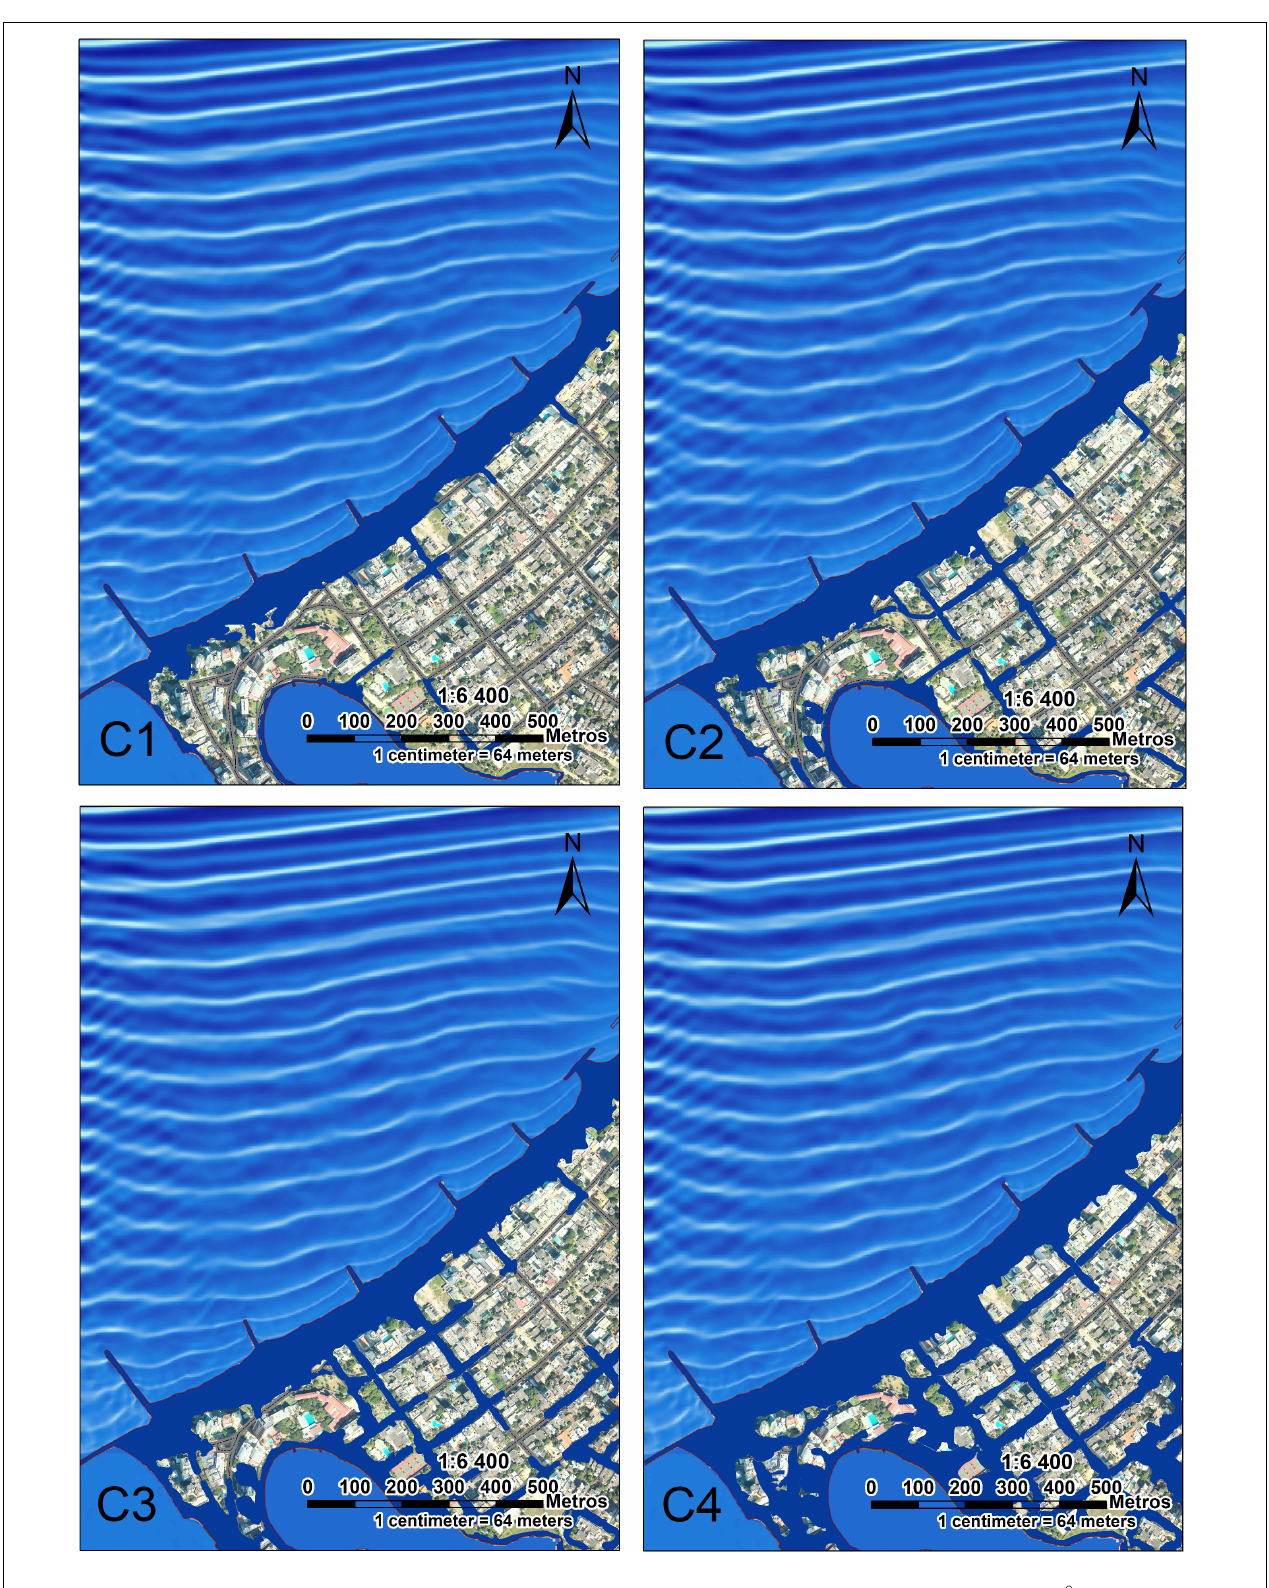
FIGURE 9 | Flooded area after the most energetic wave event coming from the NE, considering the projected SLR under the RCP 4.5 W/m 2 pathway for years (C1) 2025, (C2) 2050, (C3) 2075, and (C4) 2100. Also see C1–C4 cases in Table 3 .